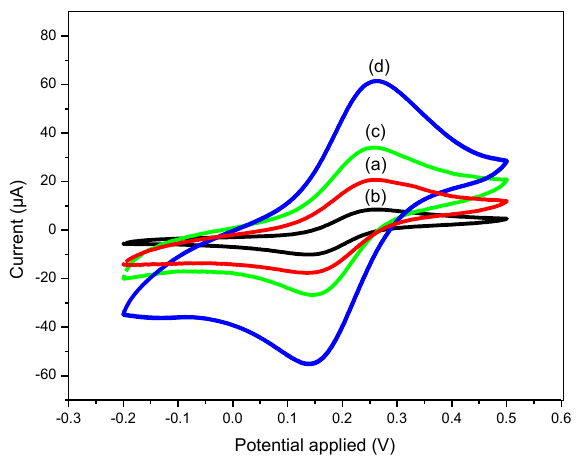
Figure 9. MB current peak of the DNA biosensor by CV ( a ) SPCE/PANI/GP ( b ) SPCE/PANI/GP/ EDC/NHS ( c ) SPCE/PANI/GP/EDC/NHS/DNA probe ( d ) SPCE/PANI/GP/EDC/NHS/DNA-DNA